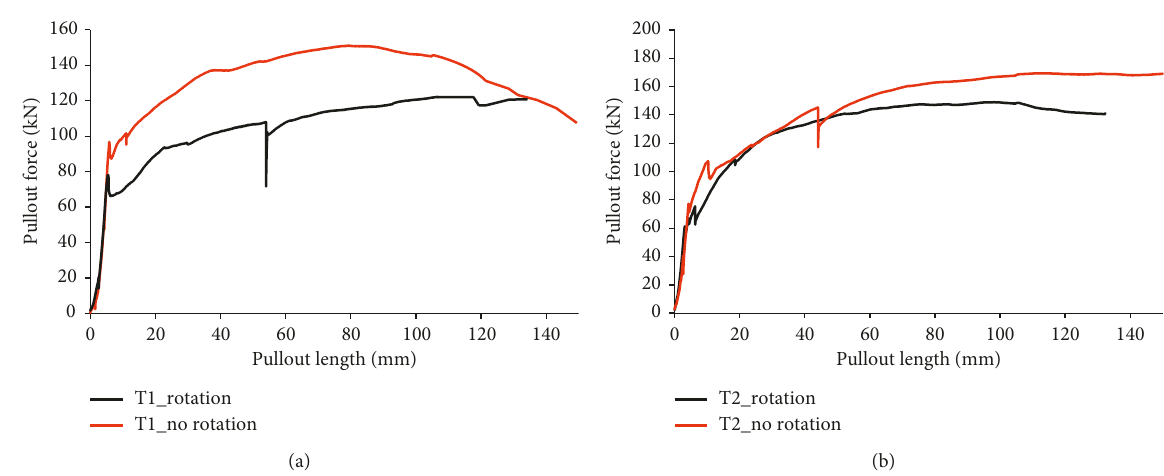
Figure 5: Results of cable bolt in DEPTs with and without a rotator. (a) Test results of group T1. (b) Test results of group